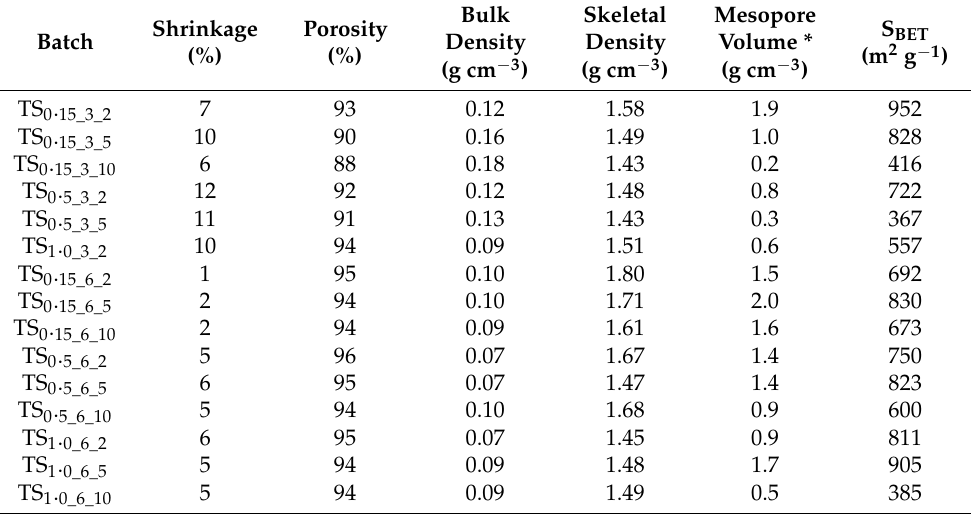
Table 1. Determined shrinkage percentage, porosity, bulk density, skeletal density values, meso- pore volume (* up to 40 nm) and specific surface area of the prepared tannin-silica aerogels using a